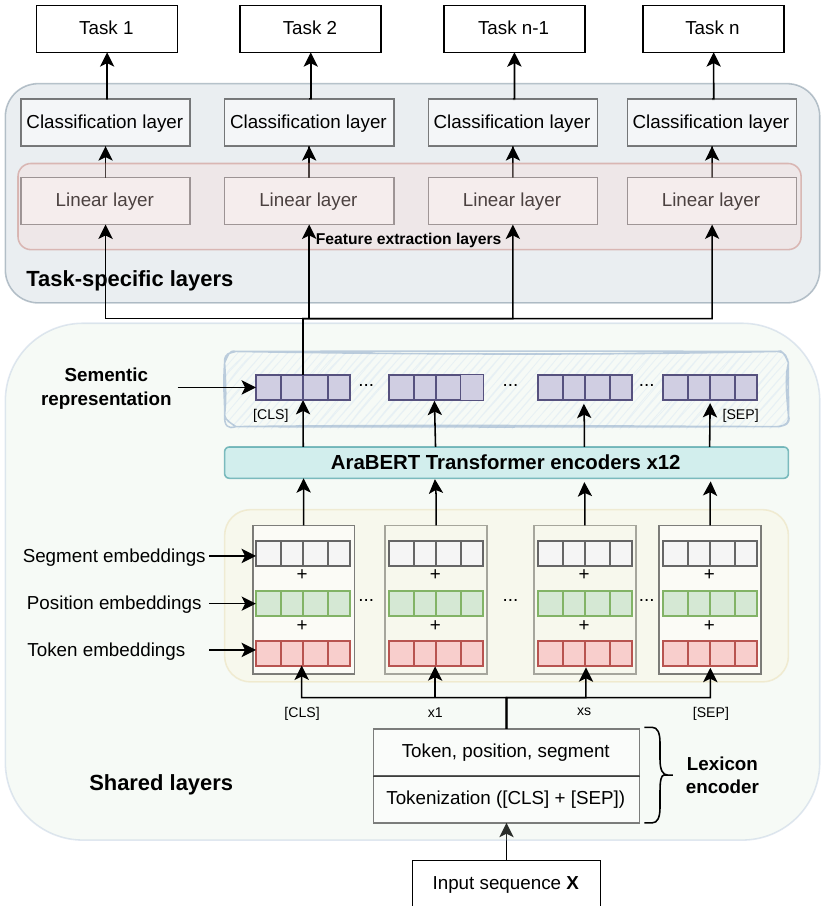
Figure 1. The feature extraction model architecture based on MTL and